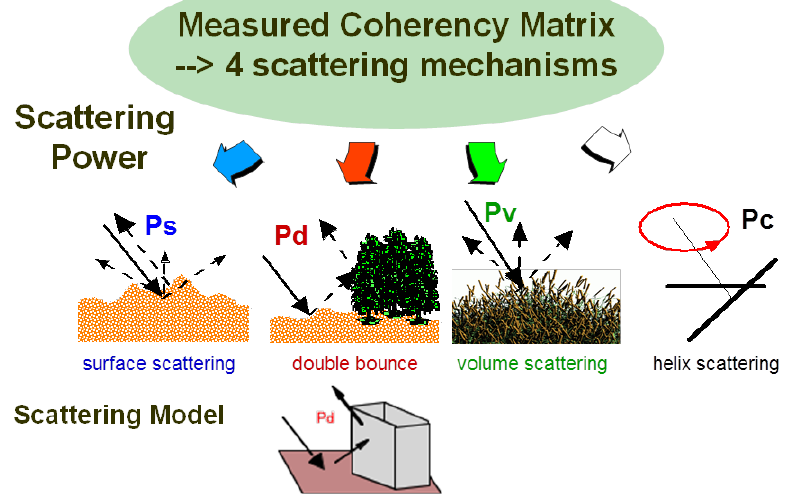
Figure 1. Schematic diagram of the four-component scattering power decomposition with the coherency matrix. Measured scattering matrix [ S ] is transformed to coherency matrix [ T ] and is decomposed into the surface scattering power P s , the double-bounce scattering power P d , the volume scattering power P v and the helix scattering power P c